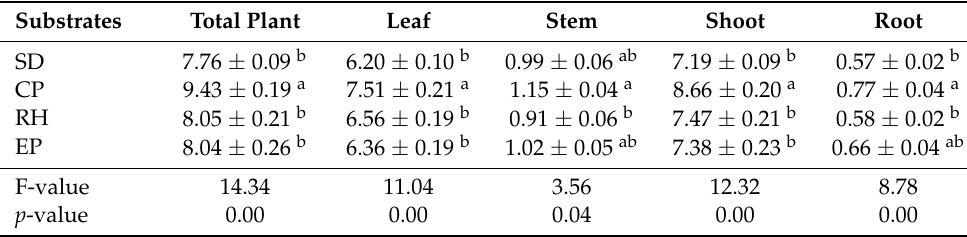
Table 4. Dry biomass (g) assimilation in plant, leaves, stem, shoot, and root influenced by different growing media.